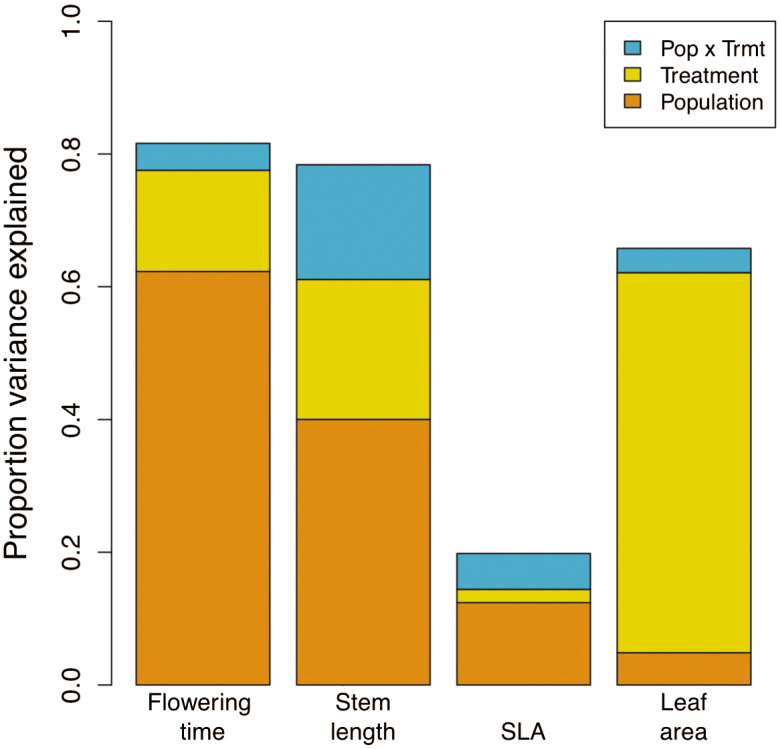
Decomposition of variance in trait means explained by experimental treatment, source population and their interaction. All effects were significant at the P < 0.01 level or less, except for the treatment × population interactions for SLA and leaf area, which were non-significant.